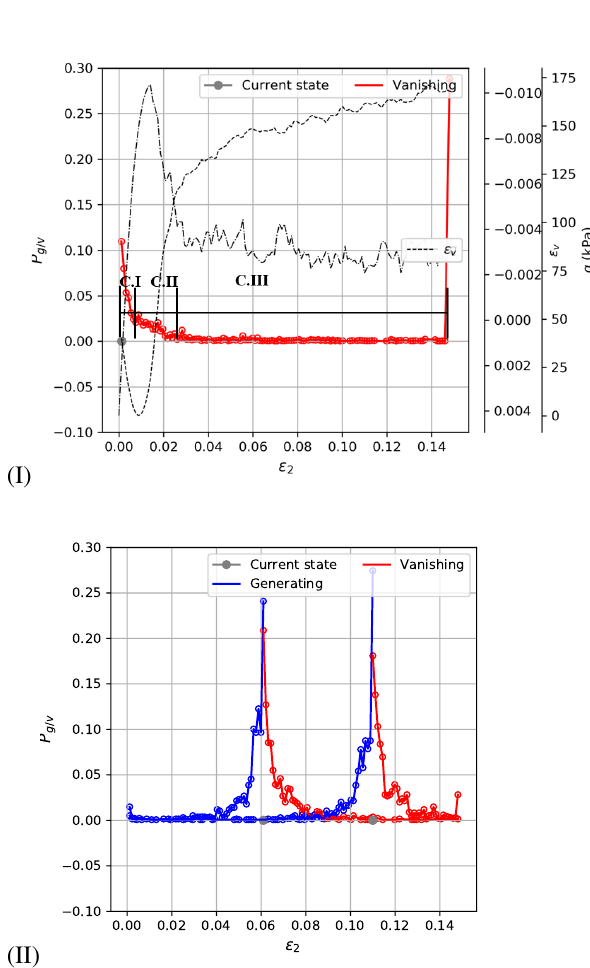
Figure 4. Lifespan and life expectancy probabilities of chained particles at the initial state considering the whole sample (I) and two critical states within the shear band